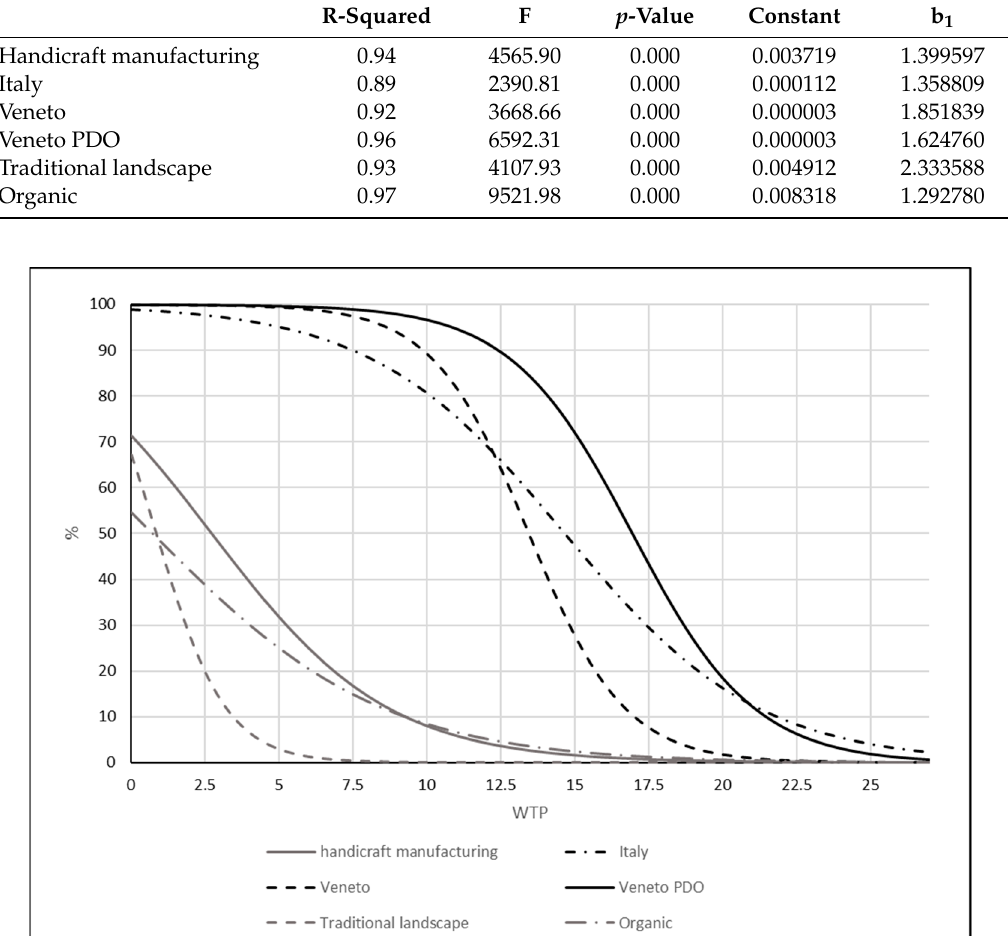
Table 6. Estimated complementary cumulative frequency distribution functions.